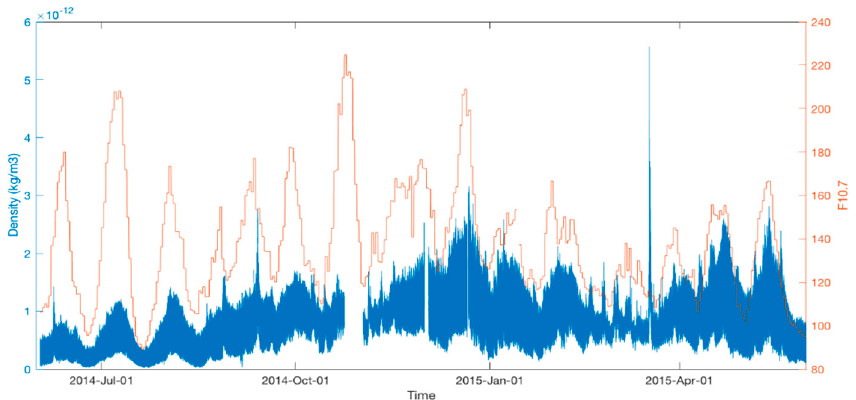
Figure 8. Density and F 10.7 variations over a year. Blue and orange colors represent density and F 10.7 . F 10.7 is presented in the so – called solar flux units, sfu, equal to 10 − 22 W/(m 2 ∙ Hz).